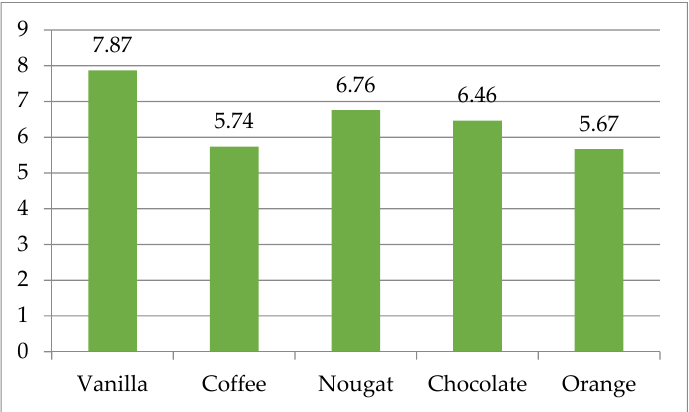
Figure 9. Conscious evaluation of tested aromas under laboratory conditions.